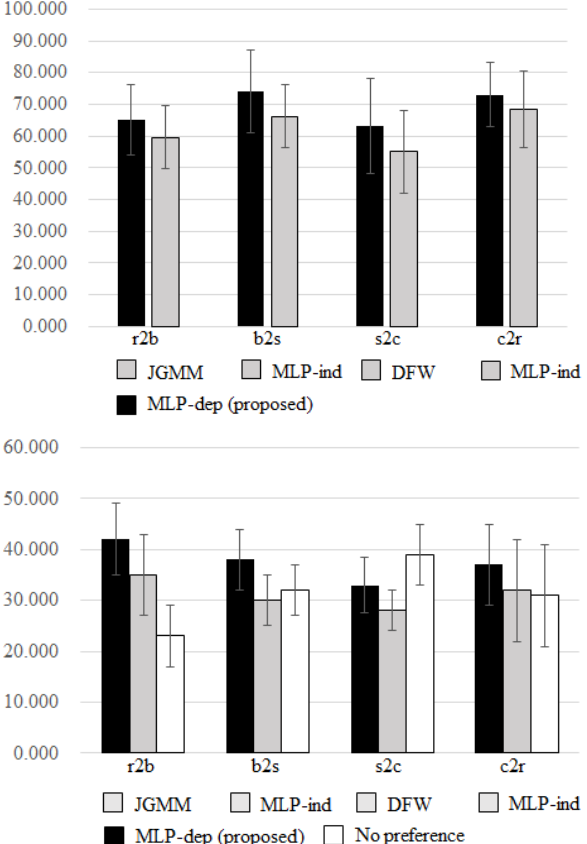
Figure 8. Subjective evaluation results with 95% confidence interval. Top: ABX test results, Bottom: Preference test